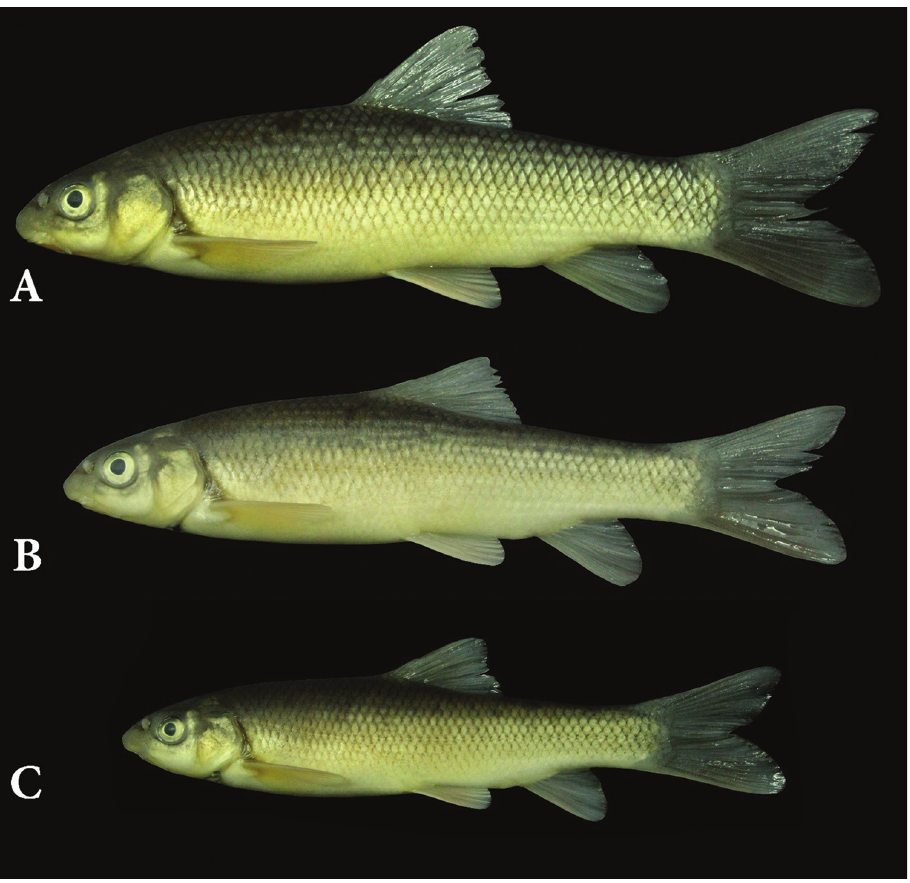
Figure 6. Capoeta razii sp. n., paratypes; A IMNRF-UT-4, SL: 130 mm B IMNRF-UT-12, SL: 115 mm C IMNRF-UT-3, SL: 99